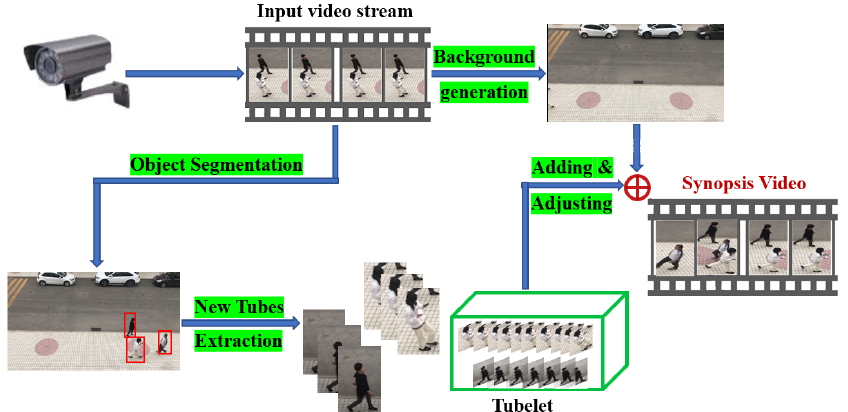
Figure 1. The online video synopsis framework.